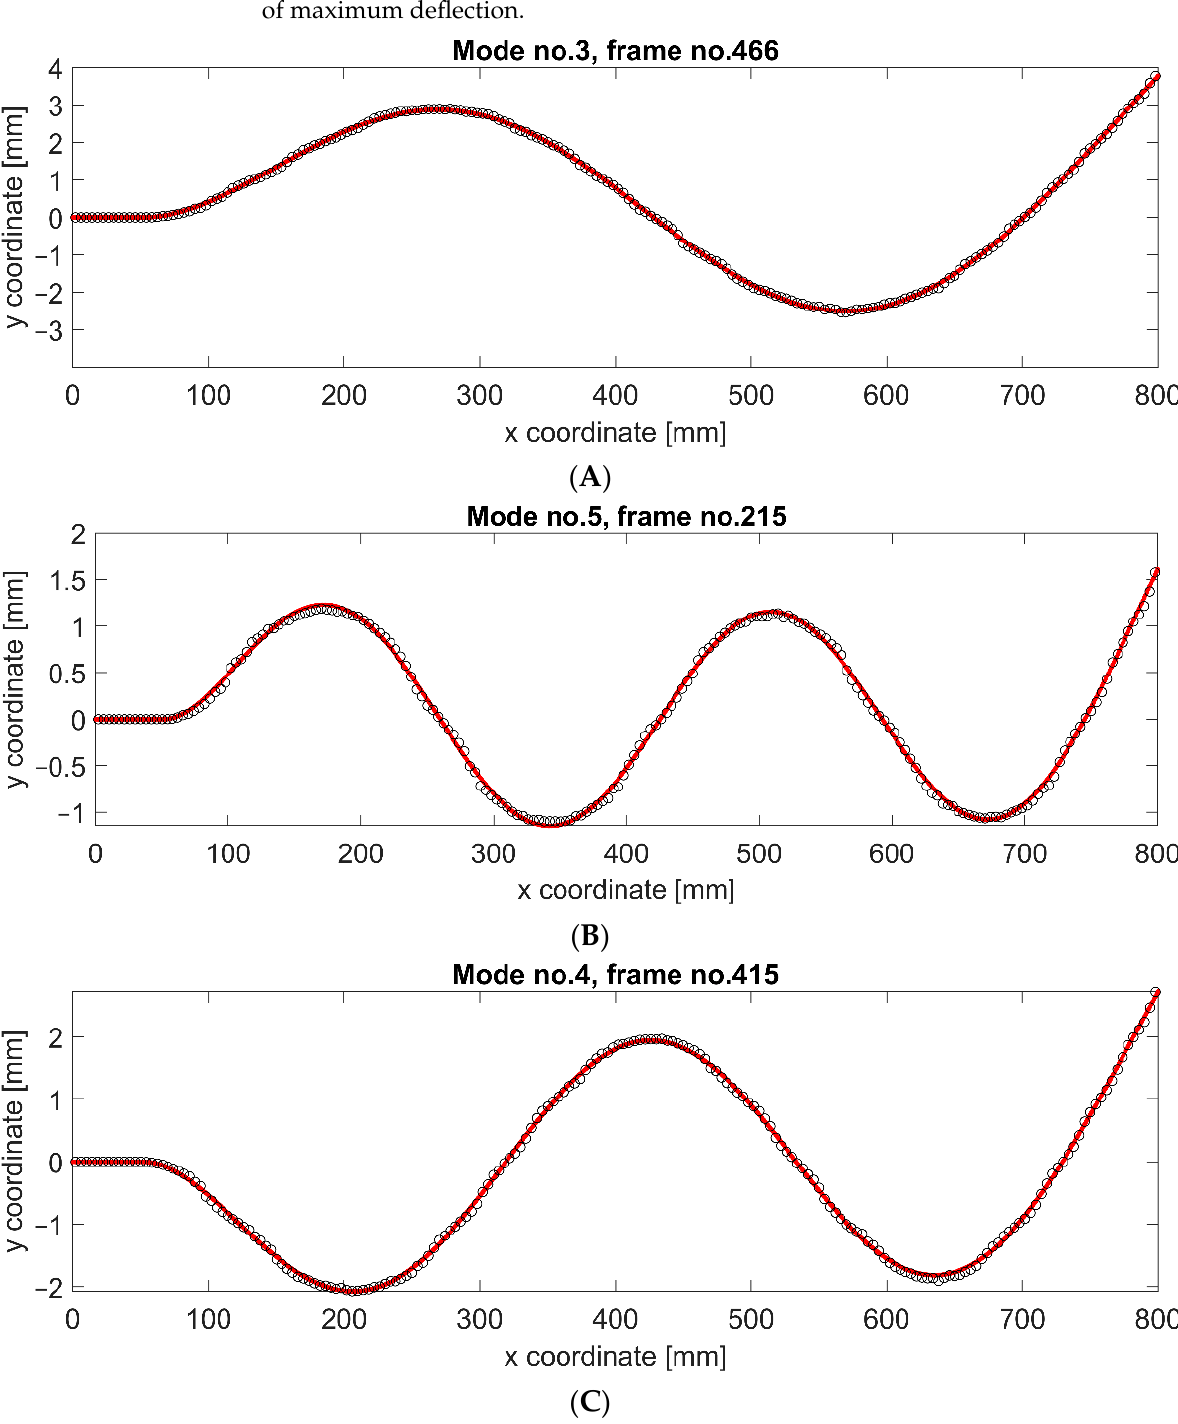
Figure 10. Mode shapes of cantilever beam computed using synthetic images with RSP employing DIC processing technique (circles), and numerical results from FEA (red line): mode no. 3 ( A ), mode no. 4 ( B ), and mode no. 5 ( C ).